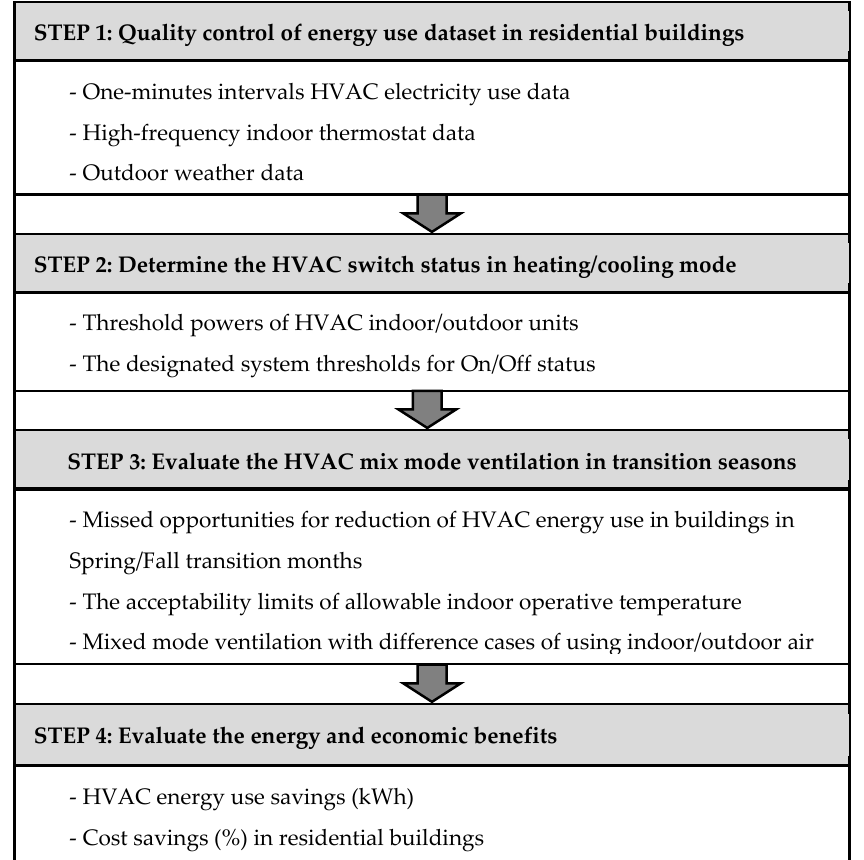
Figure 1. Methodology for evaluation of energy and economic benefits for mixed-mode